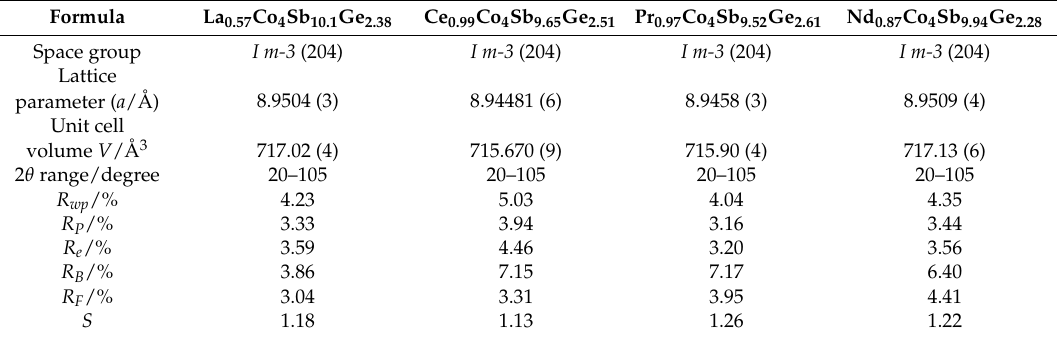
Table 2. Crystallographic data and R indices of Rietveld analysis.